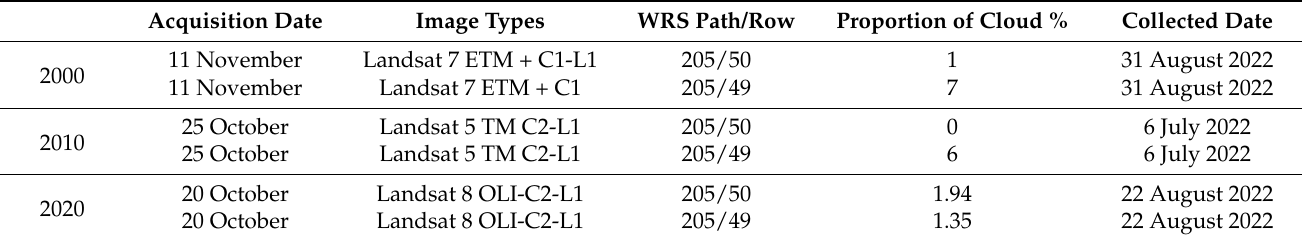
Table 1. List the satellite images used for the study and their